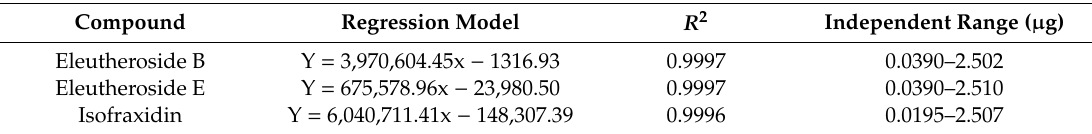
Table 2. Prepared model of linear regression with ranged of known concentrations as independent and the peak area as